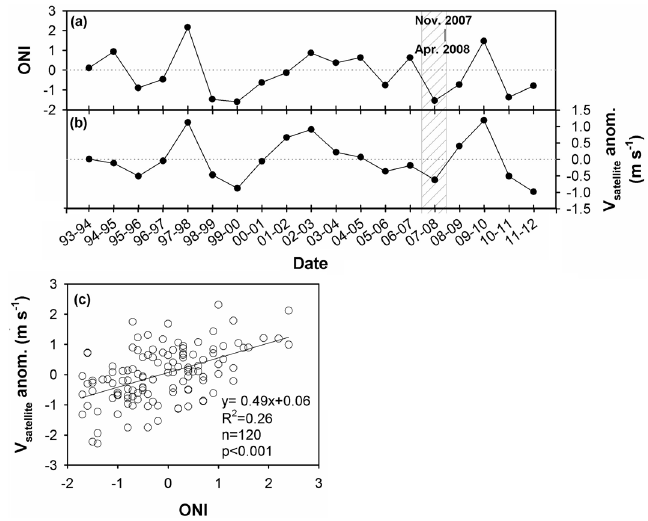
Figure 7. The ( a ) Oceanic Niño Index, ( b ) wind anomaly between Nov. and April from 1993 to 2012, and ( c ) the wind anomaly plotted against ONI.